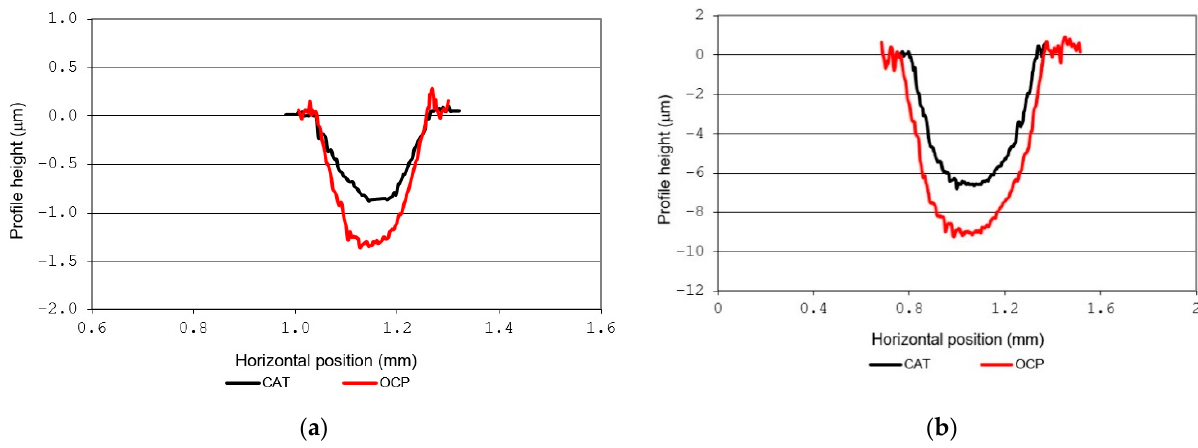
Figure 7. Profiles shape comparison of the wear traces of the investigated coatings after tribocorrosion tests at an open circuit potential and cathodic potential: ( a ) Cr/CrN PVD, ( b ) gas nitrided with subsequent oxidation and impregnation. Table 6. An analysis of tribocorrosion wear components under the load of 13 N.